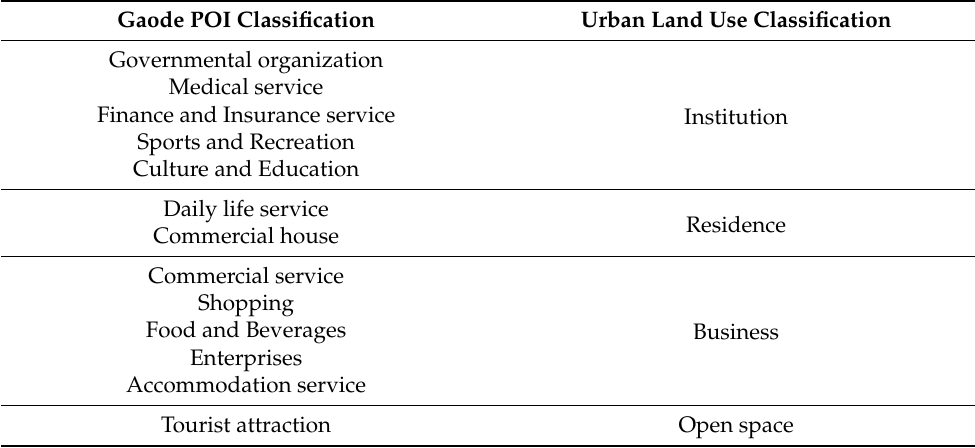
Table 1. The framework used for aggregating initial Gaode POI